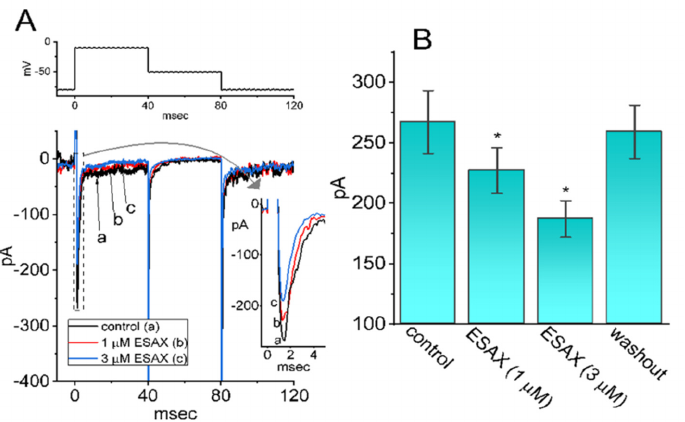
Figure 7. Effect if ESAX on I Na is present in MMQ pituitary lactotrophs. In this series of experiments, we kept cells bathed in Ca 2+ -free Tyrode’s solution and the electrodes were backfilled with Cs + -containing solution. As whole-cell configuration was firmly established, we voltage-clamped the cell at − 80 mV and the depolarizing voltage step to − 10 mV followed by return to − 50 mV was delivered to it. ( A ) Representative I Na traces in response to depolarizing command pulses (indicated in the upper part). (a): control; (b): 1 μ M ESAX; (c): 3 μ M ESAX. Inset in the right side indicates an expanded record from dashed box. ( B ) Summary of the data showing effect of ESAX (1 or 3 μ M) on peak amplitude of I Na in MMQ cells (mean ± SEM; n = 8 for each bar). Current amplitude was measured at the start of 40 ms depolarizing pulse from − 80 to − 10 mV. * Significantly different from control ( p < 0.05).